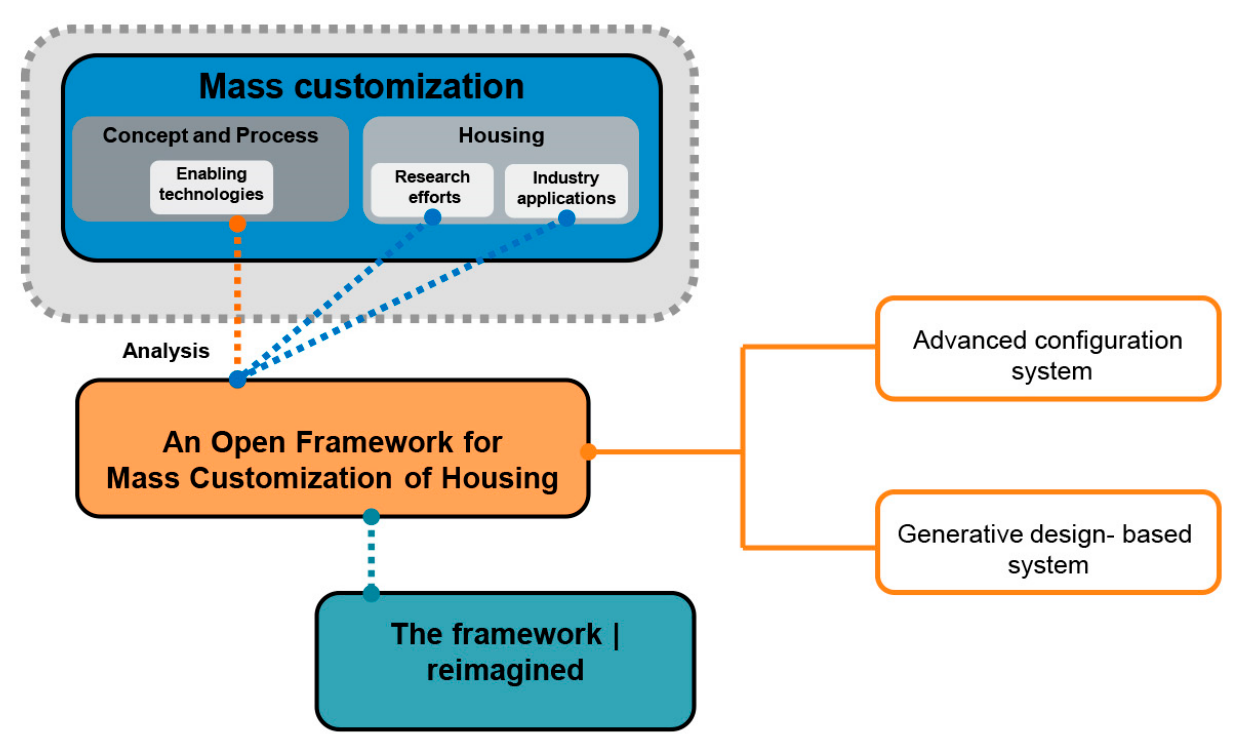
Figure 1. Diagrammatic representation of the research methodology towards devising the proposed framework.